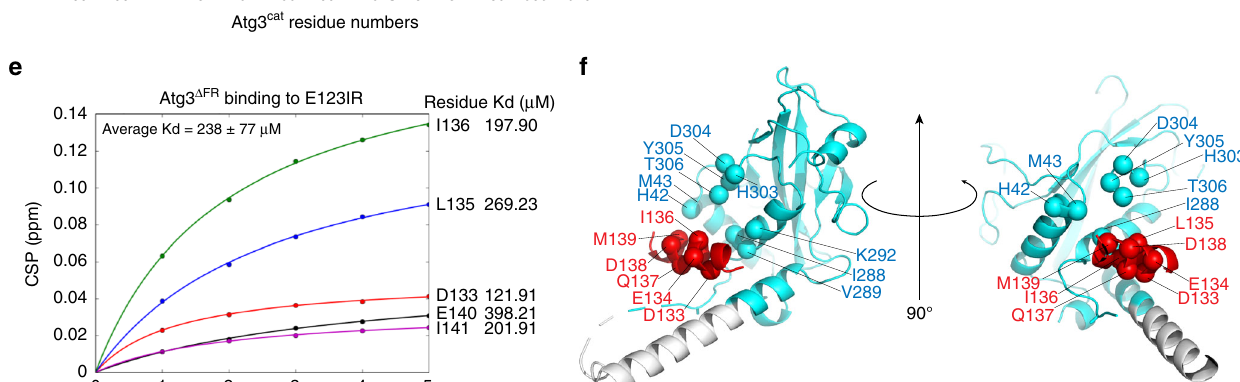
0.00.10.20.3 E123IRAtg3 FR : Atg3 Δ FR = 1 : 5